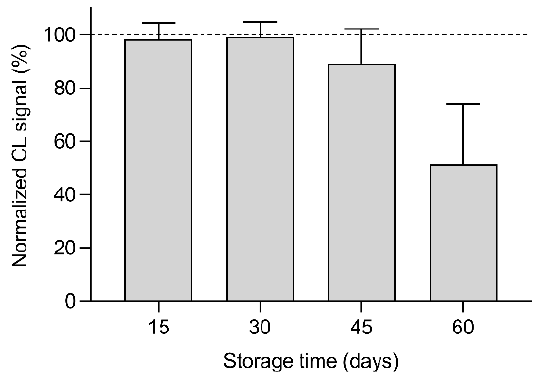
Figure 8. Changes of the CL signals obtained by analyzing 10 µL of a 250 µmol L −1 glucose standard solution using origami µPADs stored in vacuum-sealed polyethylene bags at room temperature and in the dark for different times. The CL signals were normalized to that obtained using the origami µPADs just after their production. Each value is the mean ± SD of six measures performed in five origami µPADs.